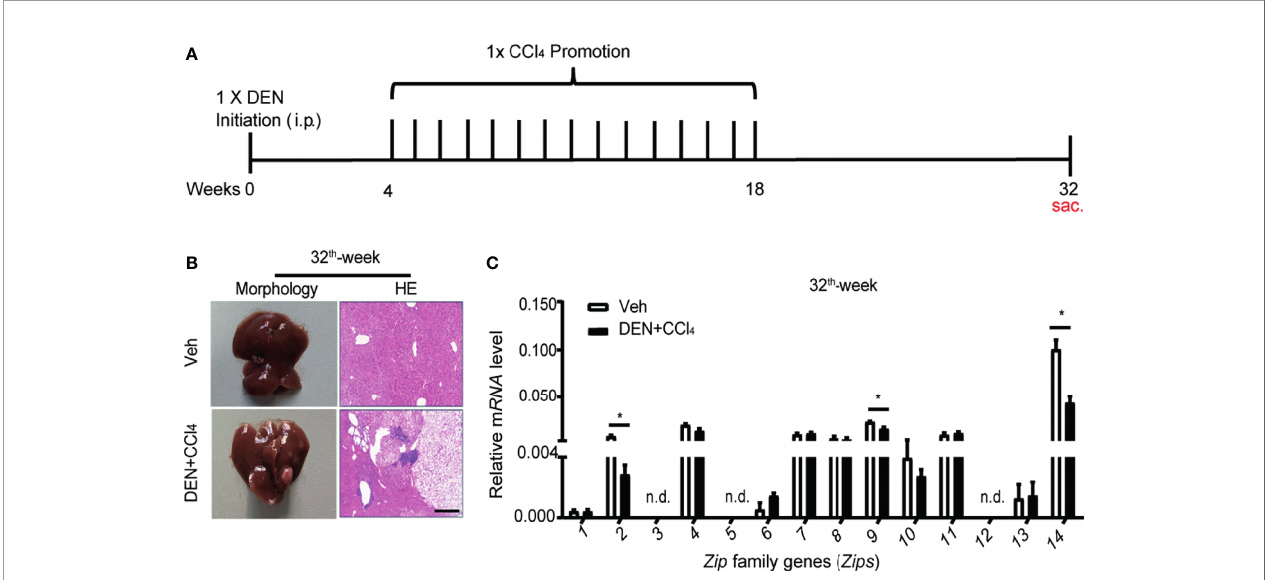
FIGURE 3 | The transcription levels of Zips with DEN and CCl 4 - induced HCC model in mice. (A) Scheme of the DEN and CCl 4 - induced HCC model. WT male mice were treated with controls (Veh) or DEN (100 mg/kg) to induce HCC. Four-week later, control mice injected with olive oil (0.5 ml/kg; i.p.), whereas DEN treated mice were received CCl 4 (0.5 ml/kg; i.p.) weekly. (B, C) After DEN treated 32 for weeks, the pathological characteristics were presented by morphology and HE staining of section of livers (B) . The mRNA levels of Zips were detected by RT-PCR (C) . Values are mean ± SD from 3 independent experiments. Using 2-tailed, unpaired Student ’ s t test (n = 7). P values are as followed: *P < 0.05, n.d., not